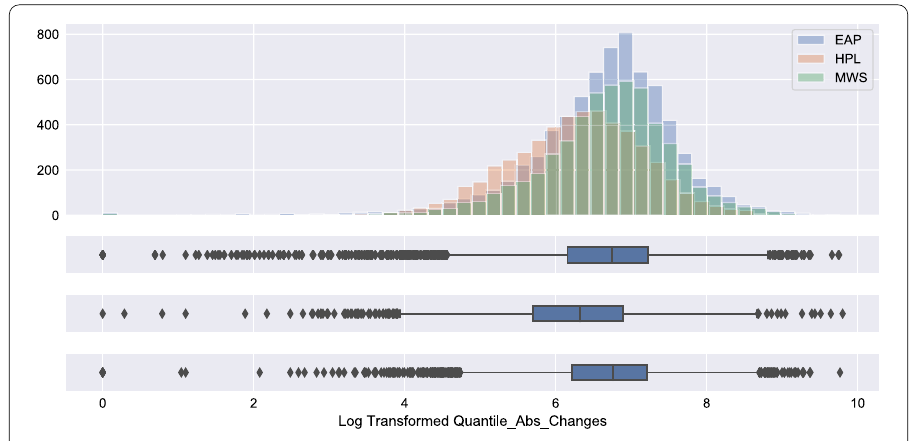
Figure 12 Exploratory analysis of stylometric feature Quantile-Abs-Changes of TFS. Distribution plots of the log-transformed feature are shown for authors EAP (blue), HPL (red) and MWS